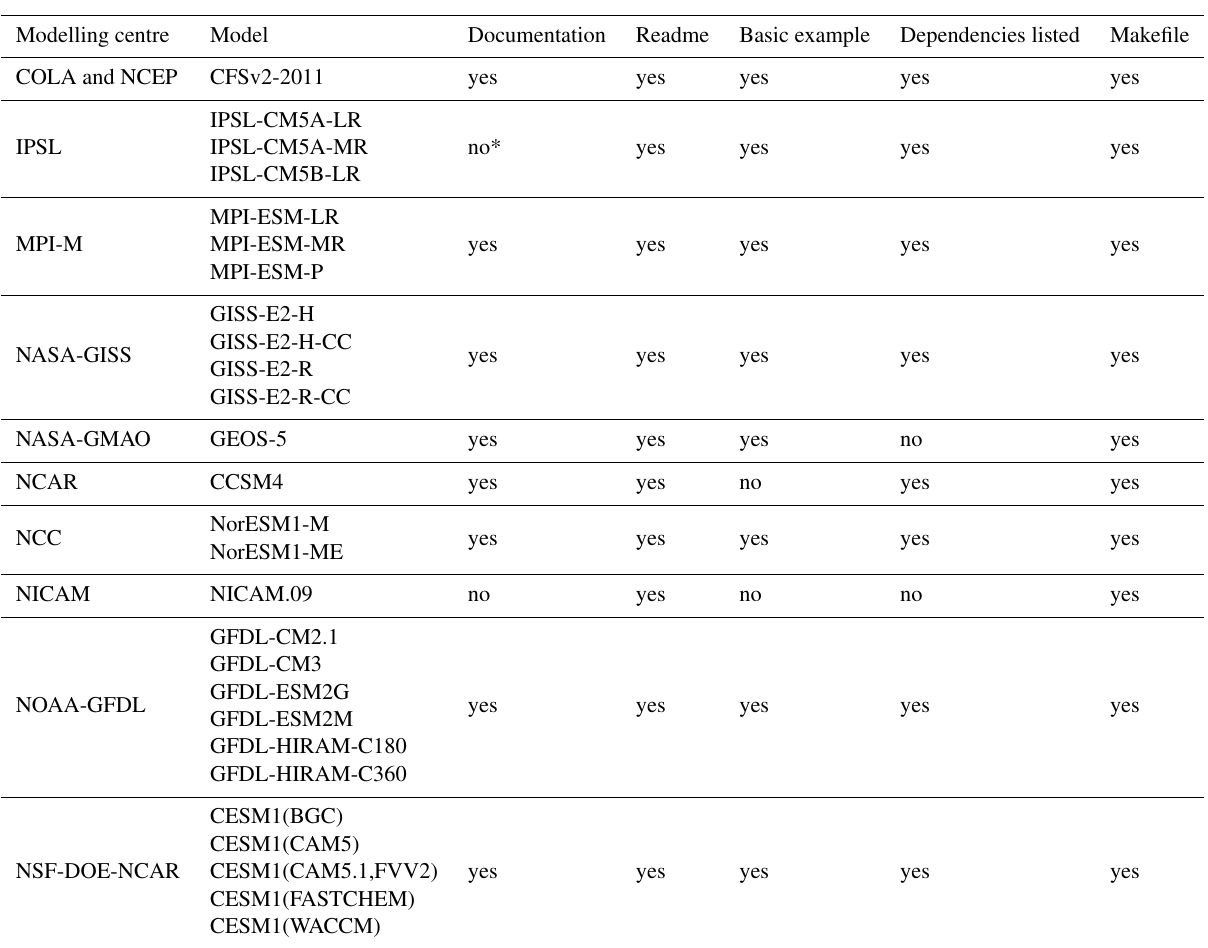
Table 4. Availability of detailed information provided with the source code for the models in order to run them. “Documentation” refers to full documentation of the model ( ∗ for IPSL models a web address/link was included to access the documentation but it did not work). “Readme” corresponds to a file containing basic explanations on the files part of the model and basic instructions. “Basic example” refers to whether an example to explain the model is included. “Dependencies” refers to the basic information on libraries, compilers, or any other software and its version needed to run the model. “Makefile” refers to the existence of a single file that manages all the processes of compilation and model